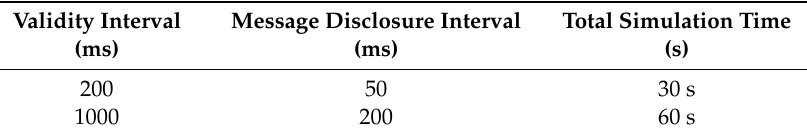
Table 4. Time parameters used to perform test